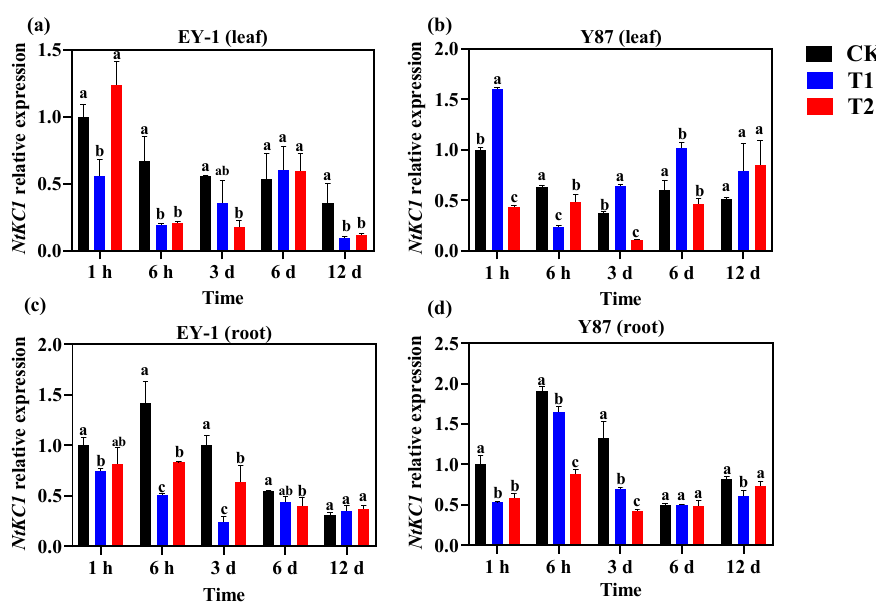
Figure 7. Relative expression levels of the NtKC1 gene in EY-1 leaf ( a ), root ( c ) and Y87 leaf ( b ), root ( d ) as determined by real-time-PCR. CK, control; T1, topping; T2, IAA application after topping. The mean ± SE of three replicate samples are shown as error bars. Means with same lowercase letters have no significant difference ( p = 0.05) in the LSD test.